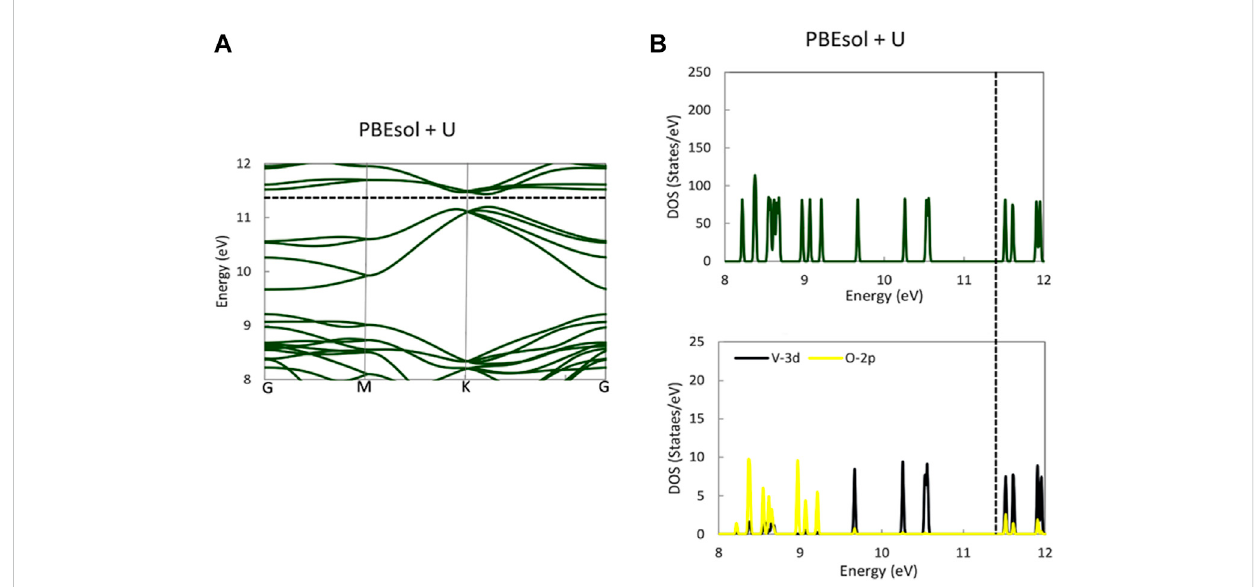
FIGURE 4 Band structure (A) and PDOS (B) of the VO 2 (M) structure for V-3d, O-2p, and total DOS predicted by the PBEsol + U functional. The Fermi energy is aligned with the dashed